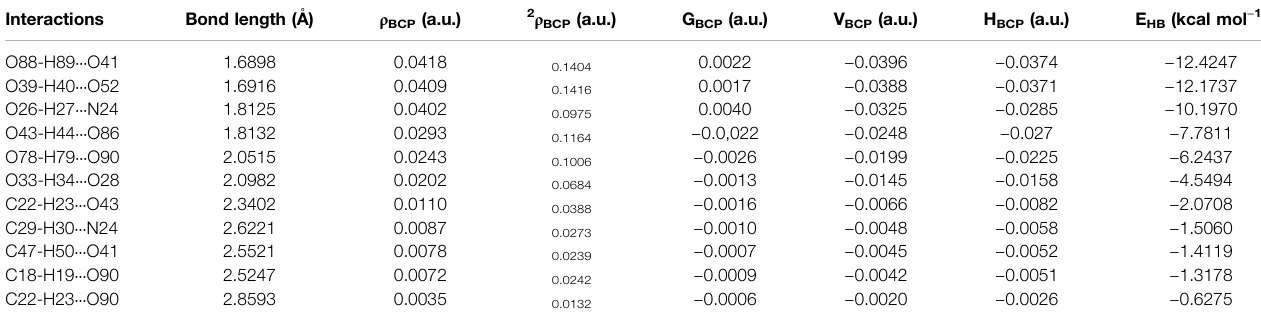
TABLE 2 | Geometrical parameter (bond-length) and topological parameters for bonds of interacting atoms of intra- and intermolecular hydrogen bonding interactions of dimer model of cocrystal: electron density ( ρ BCP ), Laplacian of electron density ( ∇ 2 ρ BCP ), electron kinetic energy density (G BCP ), electron potential energy density (V BCP ), total electron energy density (H BCP ) at bond critical point (BCP) and H-bond energy (E HB ). Interactions Bond length (A ̊